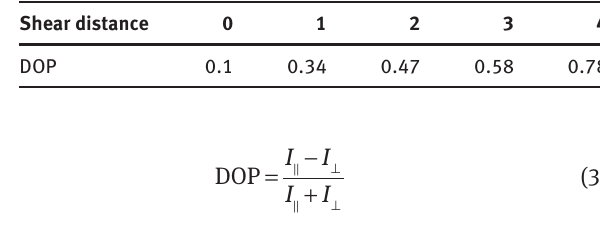
Table 1: The DOP of random laser from DDPDLCs with different shear distances. Shear